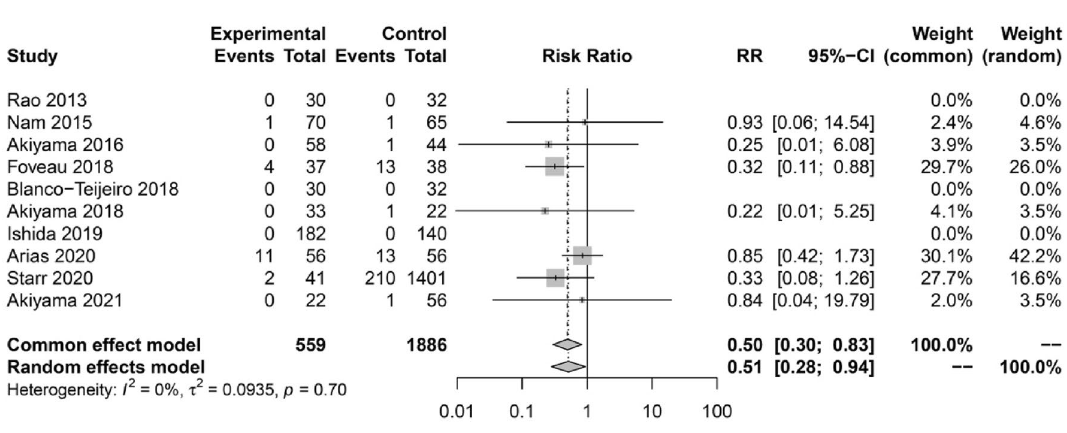
Figure 4. Forest plot showing the risk ratio (RR) and 95% confidence intervals (CI) comparing the rate of RD recurrence between